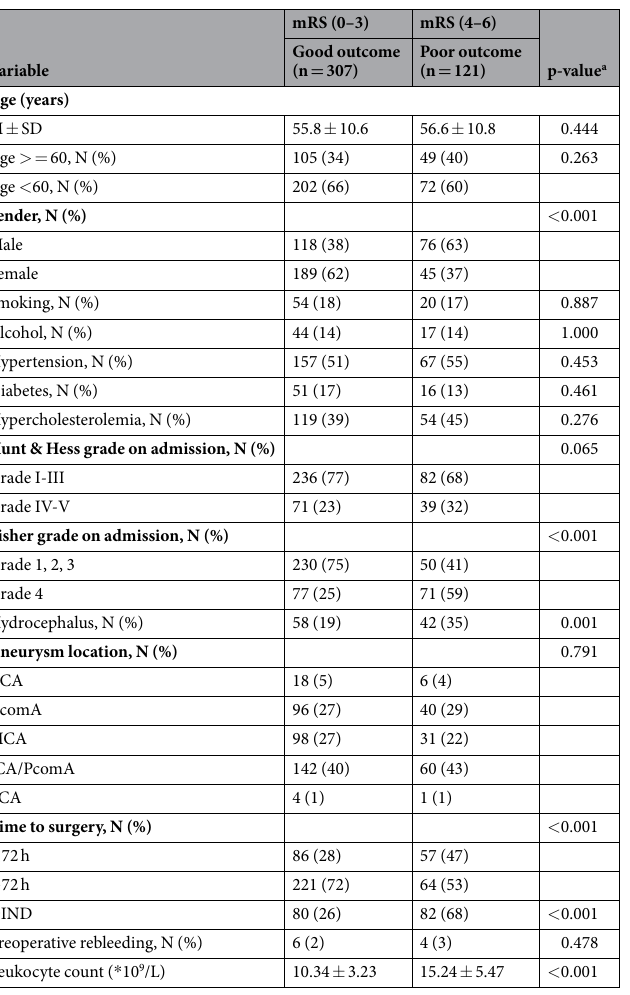
Table 1. Characteristics of 428 consecutive patients with ruptured CA. mRS = modified Rankin Scale; ACA = anterior cerebral artery; ACoA = anterior communicating artery; MCA = middle cerebral artery; ICA = Internal Carotid Artery; PcomA = posterior communicating artery; PCA = posterior cerebral artery; DIND = delayed ischemic neurological